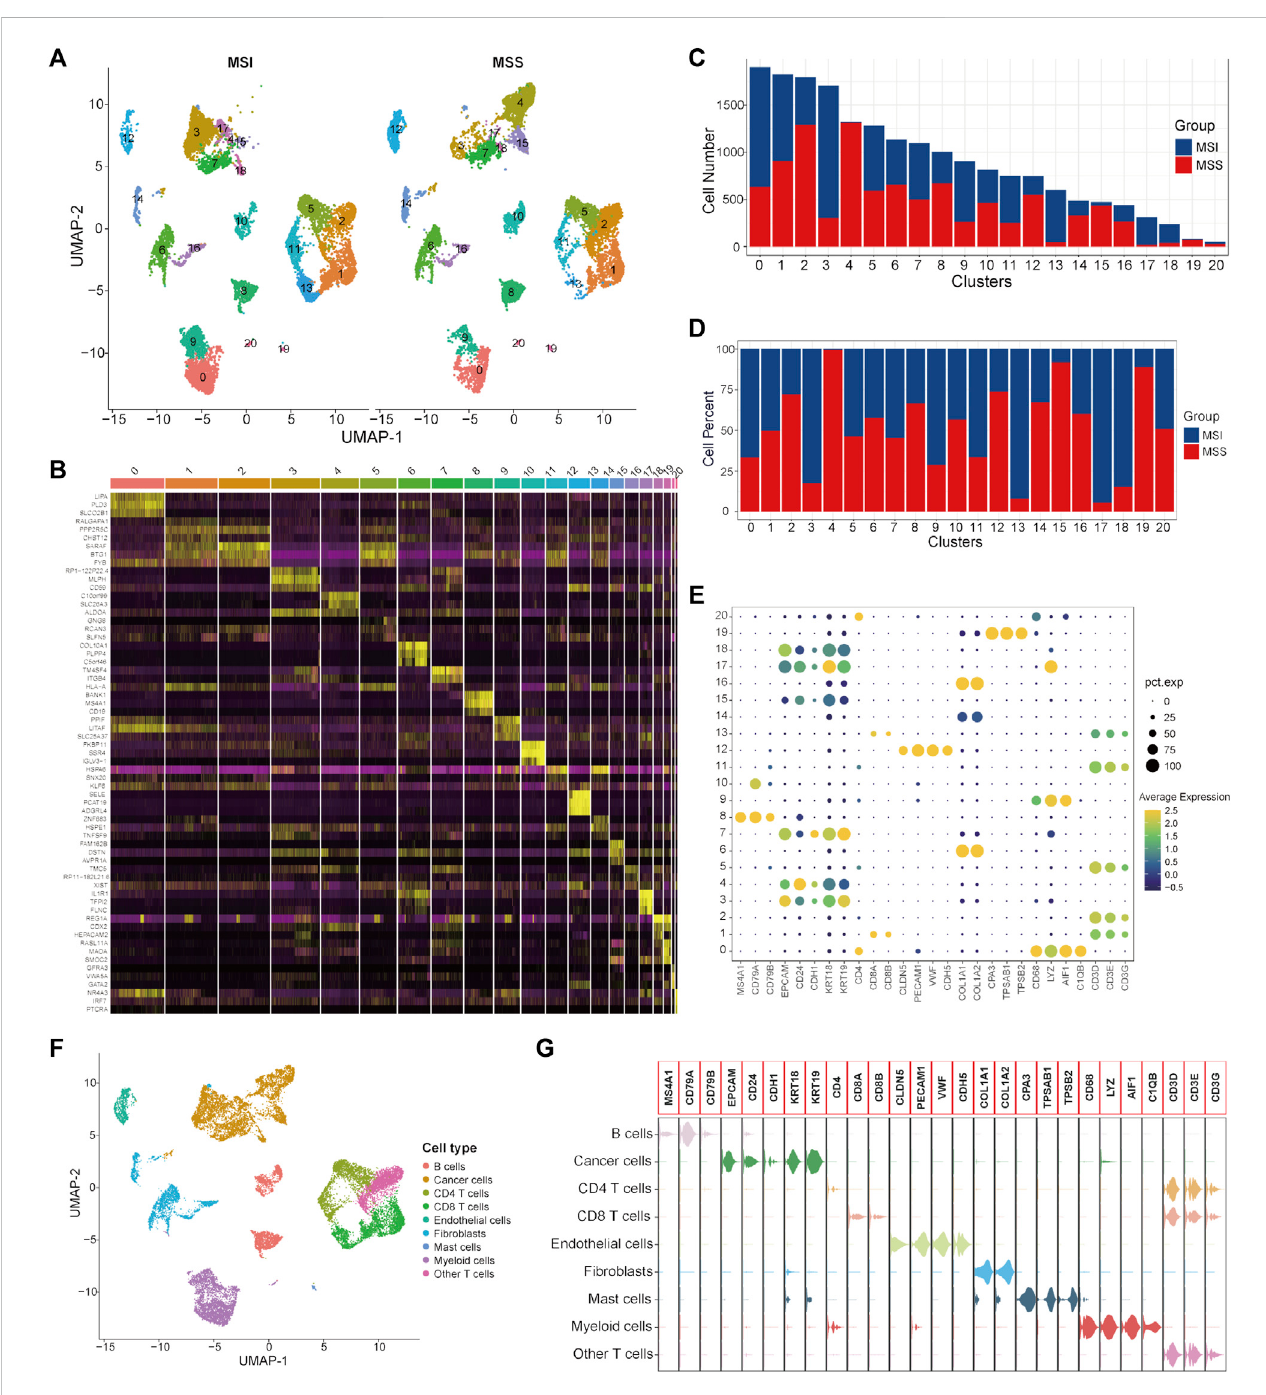
FIGURE 1 Single-cell atlas of MSI and MSS CRC patients in the scRNA training cohort. (A) UMAP and cluster analyses (Clusters 0 – 20) of 9366 single cells from CRC patients with MSI status and 9603 cells with MSS status. (B) The heatmap visualizes the top three signi fi cantly highly expressed genes in each cell cluster. (C) CellnumbersofMSIandMSSCRC-derivedcellsinthese21cellclusters. (D) CellproportionsofMSIandMSSCRC-derivedcellsinthese21cellclusters. (E) Dot plotsvisualizethespeci fi ccellmarkergenesineachcellcluster. (F) UMAP plotofcellannotationresults. (G) Violinplots ofthespeci fi